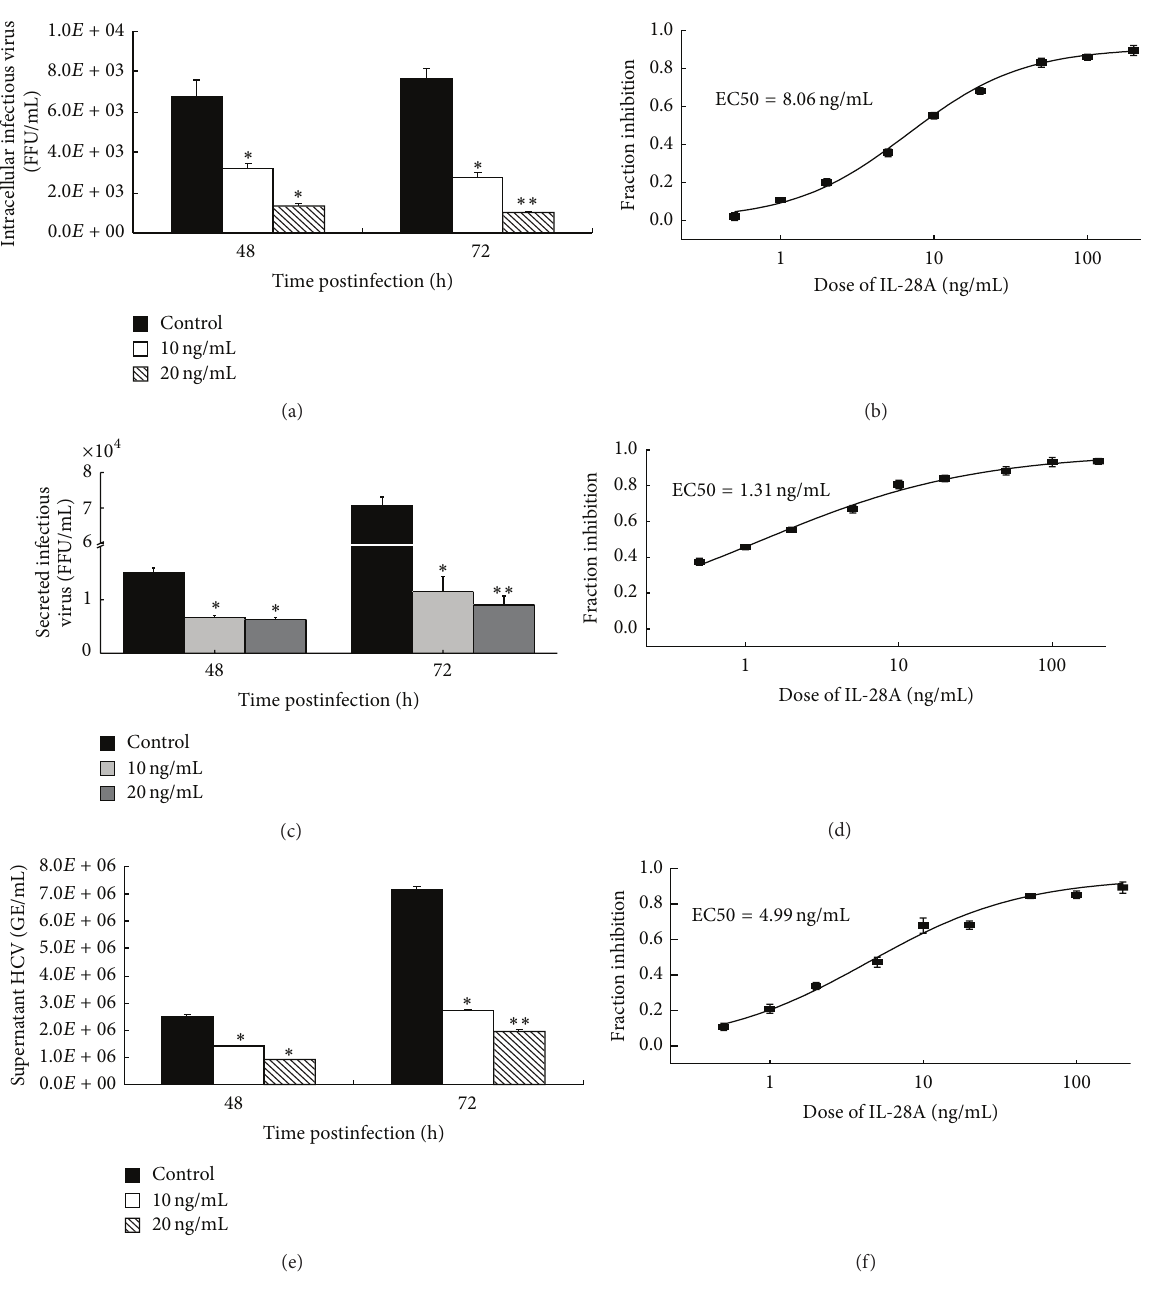
Figure 2: IL-28A inhibits assembly and release of infectious HCV particles. ((a) and (c)) Huh7.5 cells were infected with HCV (MOI = 0.1) for 6 h at 37 ∘ C. The medium was then removed and cells were incubated with IL-28A for 48 or 72 h at 37 ∘ C. The intracellular virus particles (a) and the cell culture supernatants (c) were harvested and titered by FFU (focus-forming unit) assay on naive Huh7.5 cells. (e) HCV RNA in the cell culture supernatants was extracted and detected with real-time PCR. ((b), (d), and (f)) The dose-response curves of IL-28A. (b) The intracellular virus particles were detected as described in part (a). (d) The secreted infectious virus particles were detected as described in part (c). (f) HCV genome equivalents were detected as described in part (e). The results are the average of three independent experiments performed in